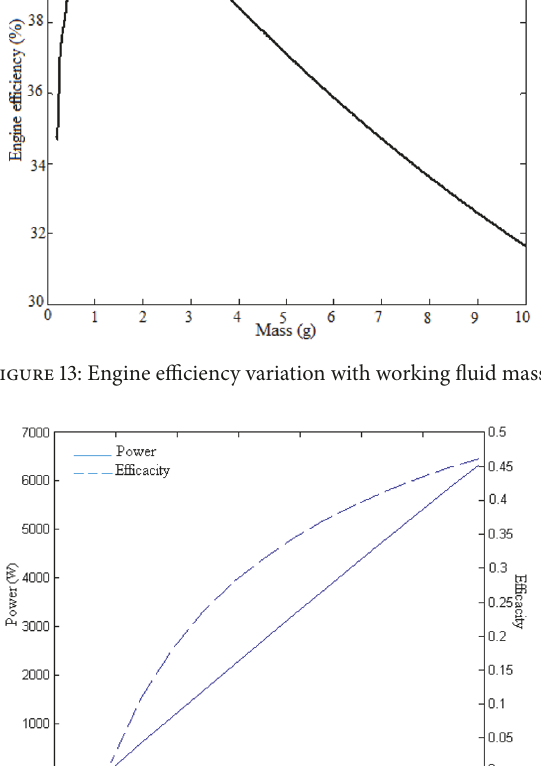
Figure 12: Power and efficiency variation with regenerator section heat capacity.